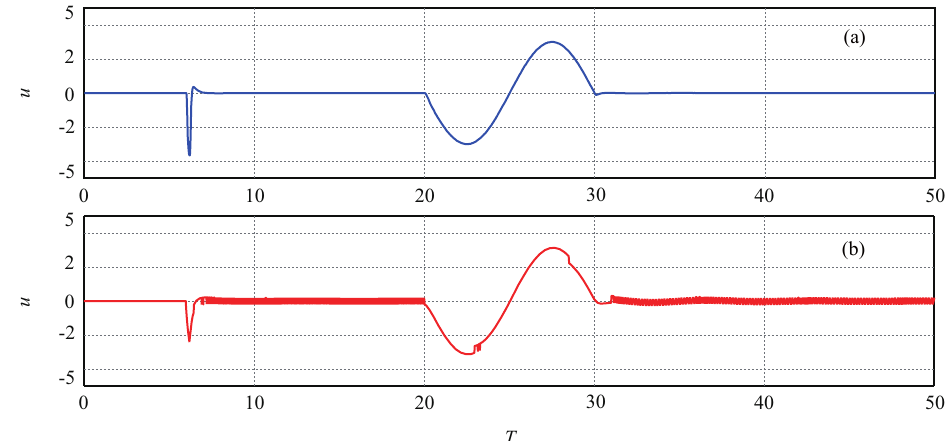
Figure 8. Robustness test results of the dimensionless control input [( a ) Proposed method; ( b ) Method in [35]].